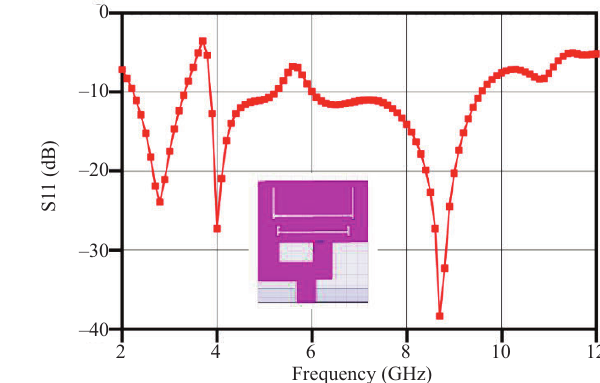
Fig. 3. Simulated S11 response with one H­shaped slot printed on the top of the radiating patch.